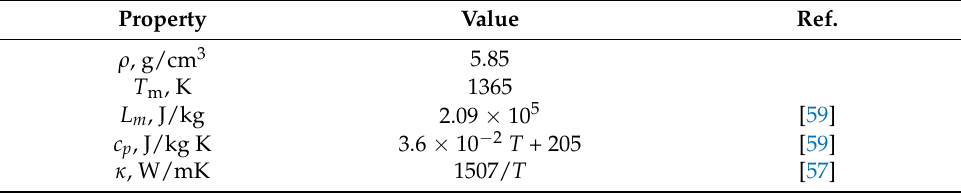
Table A13. c -CdTe—thermophysical properties.